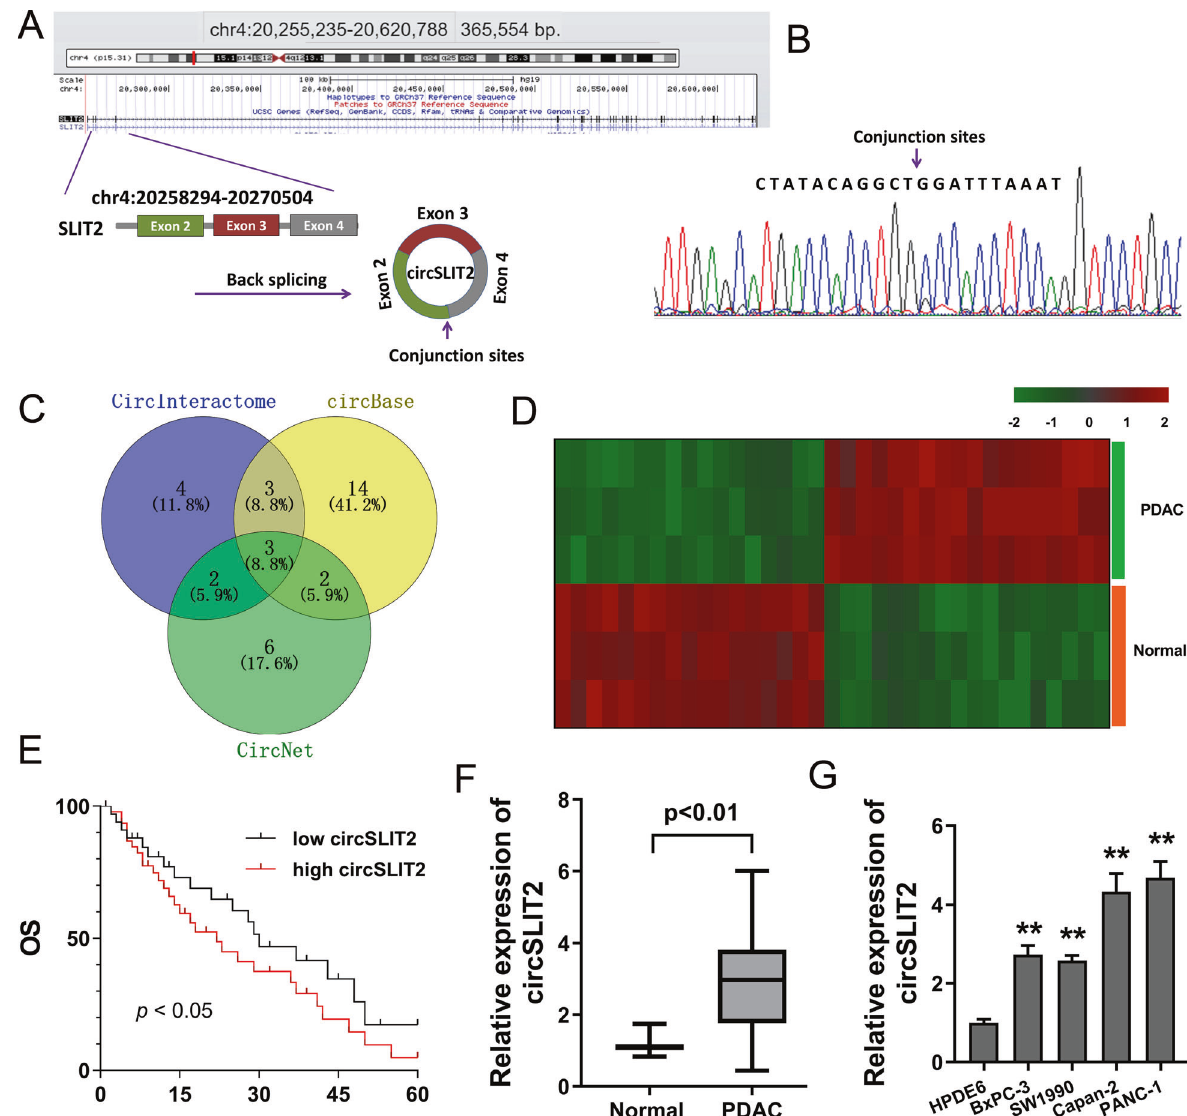
Fig. 1 CircRNA circSLIT2 was upregulated in PDAC tissue and cells. A A novel circRNA circSLIT2 (hsa_circ_0009113) was generated from the exon 4 to exon 2 with 216 spliced length. B Sanger sequencing demonstrated the full length of circSLIT2 and the conjunction sites of exon 4 and exon 2. C Venn diagram showed the candidate circRNAs from the circBase (http://www.circbase.org/), CircInteractome (https:// circinteractome.nia.nih.gov/) and CircNet (http://syslab5.nchu.edu.tw/CircNet/). D The dysregulated circRNA expression pro fi les in the PDAC tissue and normal tissue were analyzed using GEO dataset (GSE69362). E Kaplan – Meier survival curves and log-rank test were performed to evaluate the survival of PDAC individuals with high or low circSLIT2 expression. F RT-qPCR illustrated the circSLIT2 expression in the PDAC specimens and normal specimens. G RT-qPCR illustrated the circSLIT2 expression in PDAC cell